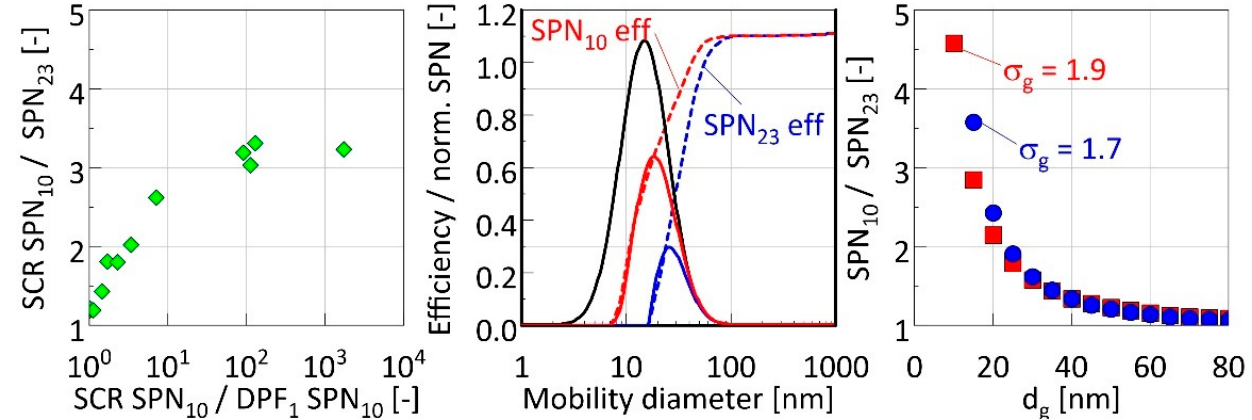
Figure 7. Left-hand panel: Quantified ratios of SPN 10 to SPN 23 as a function of the ratio of SPN 10 concentrations at the outlet of the SCR to those at the outlet of the DPF 1 for all cycles tested. Middle panel: example illustration of the fraction of a lognormal distribution detected by a SPN 10 and SPN 23 device based on typical detection efficiencies for a 15 nm size distribution. Right panel: Calculated ratios of SPN 10 to SPN 23 concentration ratios as a function of geometric mean diameters (d g ) for two geometric standard deviations ( σ g ). DPF = Diesel Particulate Filter; SCR = Selective Catalytic Reduction; SPN = Solid Particle Number.